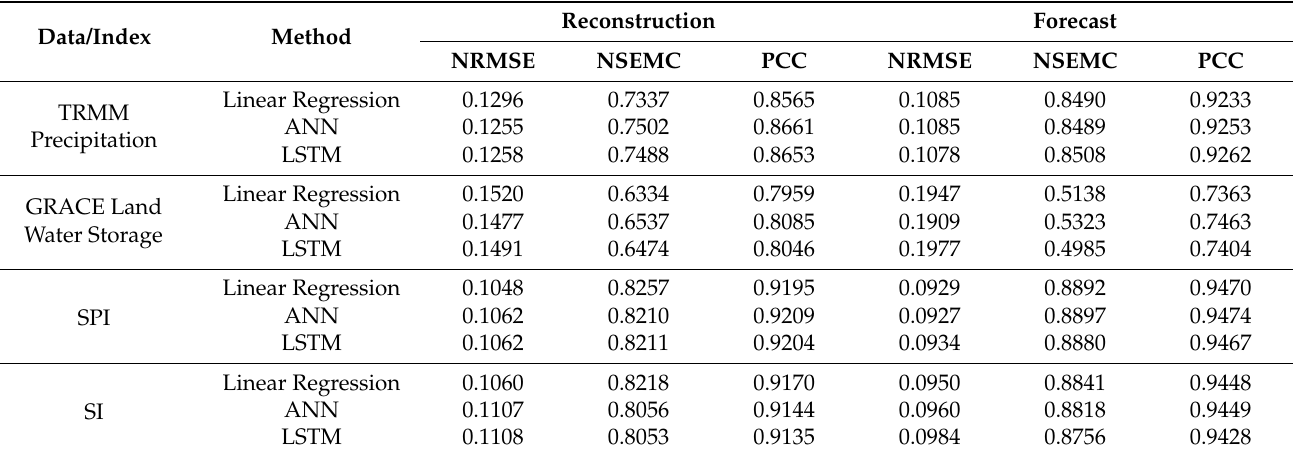
Table 1. Evaluation of runoff reconstruction and